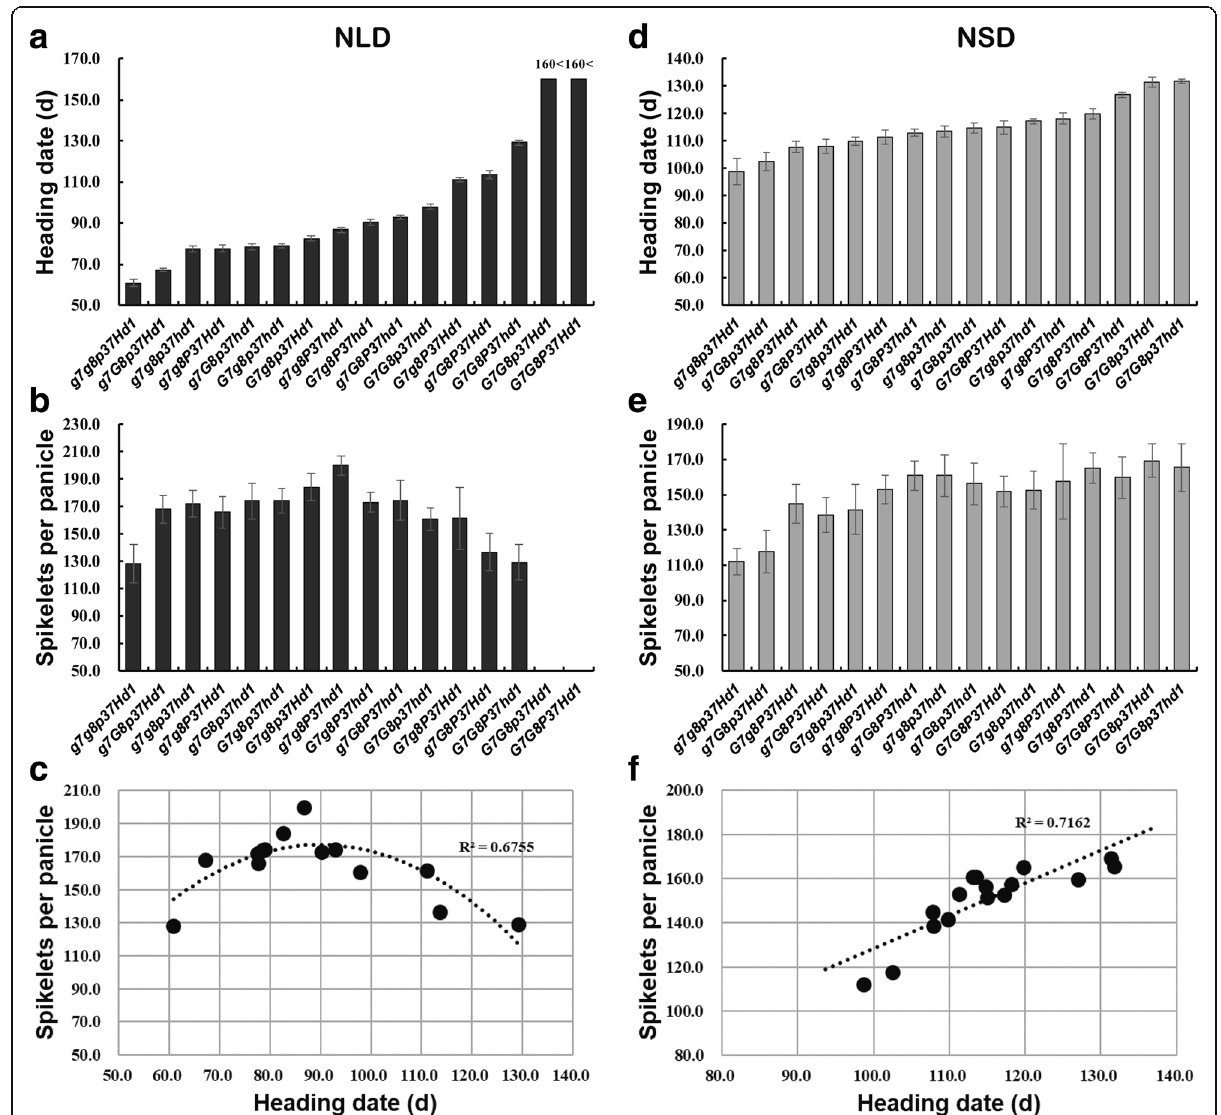
Fig. 5 Performances of 16 4-gene homozygous combinations on heading date, SPP under NLD and NSD conditions. Heading date ( a , d ), SPP ( b , e ) and curve-fitting plots of heading date with SPP ( c, f ) under NLD and NSD conditions, respectively. The combinations in a , b , d and e are ordered by the increasing heading date. Curves fitting the trait change in c and f are calculated by the quadratic and liner equation with R 2 values, respectively. G7 , G8 , P37 indicate functional alleles of Ghd7 , Ghd8 and PRR37 , respectively. g7 , g8 , p37 indicate nonfunctional alleles of Ghd7 , Ghd8 and PRR37 , respectively. “ 160< ” , non-heading after 160 days from sowing. 20 ≤ n ≤ 24 for each combination under NLD conditions and 10